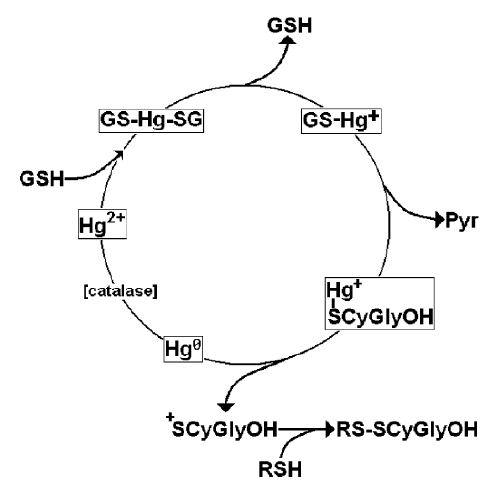
Figure 2. Proposed catalytic cycle for the depletion of the cellular pool of reduced glutathione by Mercury Re-elaborated from Reference [34]. Copyright 2006, John Wiley & Sons, Inc.